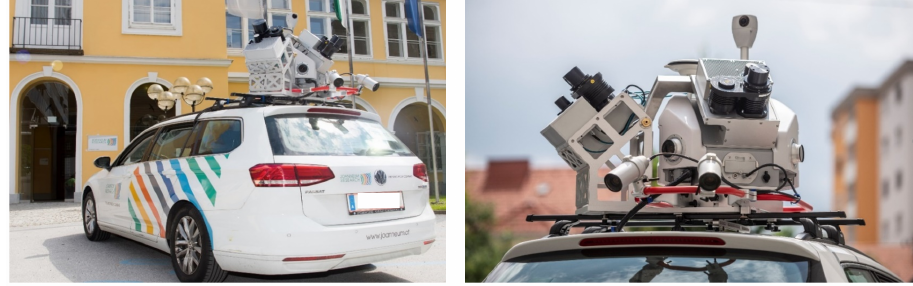
Figure 4. Leica Pegasus Two Ultimate with dual scanner configuration and two pavement cameras (Picture: © Bergmann,